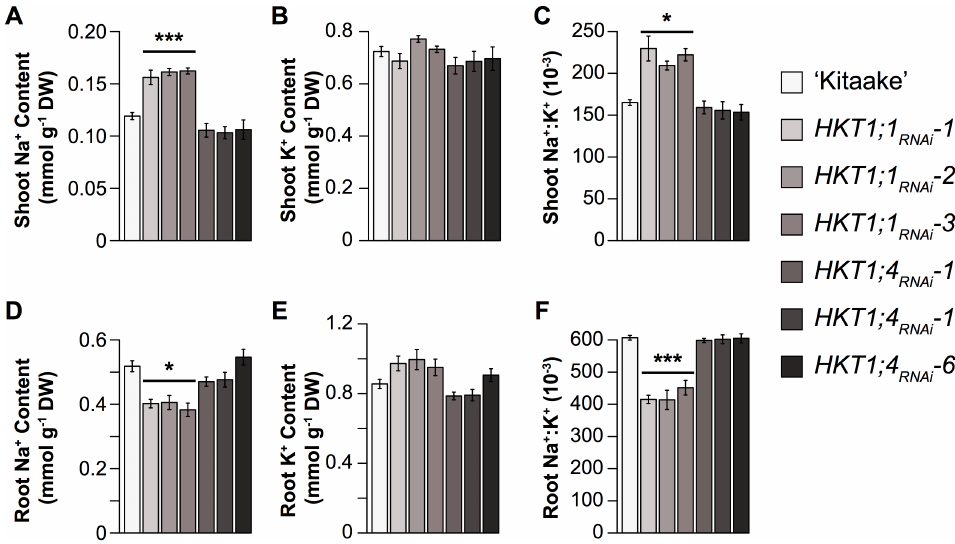
Fig 5. Root (A-C) and shoot (D-F) ion content of HKT1;1 and HKT1;4 RNAi plants. Asterisks indicate significanceas determinedusing Tukey’s HSD: *** : p < 0.001; * : p < 0.05. Pairwise comparisons were made betweenlines within each treatment. Error bars represent standarderror of the mean where n = 12–20 plants.